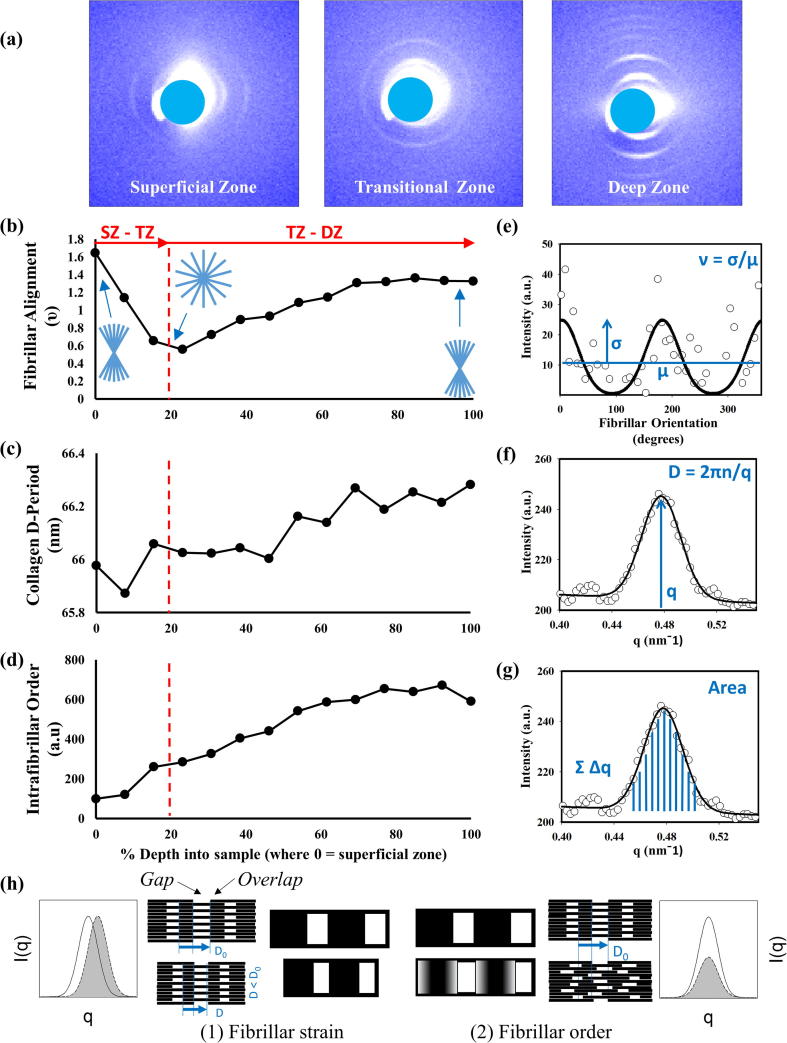
The depth-wise variation in SAXS derived parameters in bovine articular cartilage. Sample SAXS patterns from a single sample of full thickness cartilage are shown in part (a) (beam-stop region masked with a circle). The depth-wise fibrillar alignment (ν-parameter), collagen D-Period and intrafibrillar order versus depth are shown in (b)–(d) respectively. In (b), blue line-patterns show different degrees of fibrillar alignment across the tissue and the correlation with ν-parameter. A representative radial integration is shown in (e) which indicates how the ν-parameter is calculated which a representative azimuthal integration is shown in (f) and (g) showing how both D-period and intrafibrillar order are determined, respectively [40]. (h) Schematic showing the structural meaning of fibrillar strain and order, in terms of inter-molecular arrangement within the fibril and related SAXS pattern. The staggered arrangement of tropocollagen molecules is shown schematically in the centre, with the regions of high density (overlap) and low density (gap) shown at the fibrillar (centre) and intrafibrillar level (offset centre). The left images show fibrils undergoing compressive strain (shift in D-period) without intrafibrillar rearrangement (shift in meridional SAXS peak). The right image show intrafibrillar rearrangements of molecules (disordering), leading to reduction of SAXS peak intensity. As the data shown is from a single sample, no error bars are indicated on the plots. (For interpretation of the references to colour in this figure legend, the reader is referred to the web version of this article.)